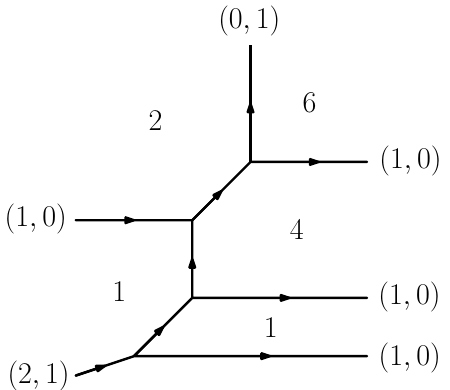
Figure 9. Example of a con(cid:12)guration of branes with a BRST